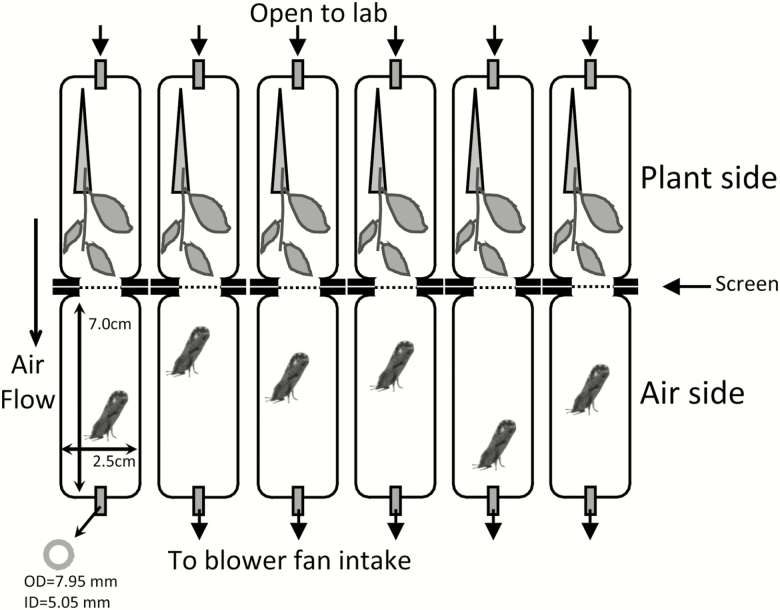
Schematic of the six test chambers for measuring the ability of Diaphorina citri to pass through screens of different mesh sizes. All insects start on the air side of the test arena and must pass through a screen to reach food and water. The psyllid images are about 10× life size relative to the scale of the drawing. Each arena would have multiple insects for each run of the experiment. See Tables 2 and 3 for sample sizes.